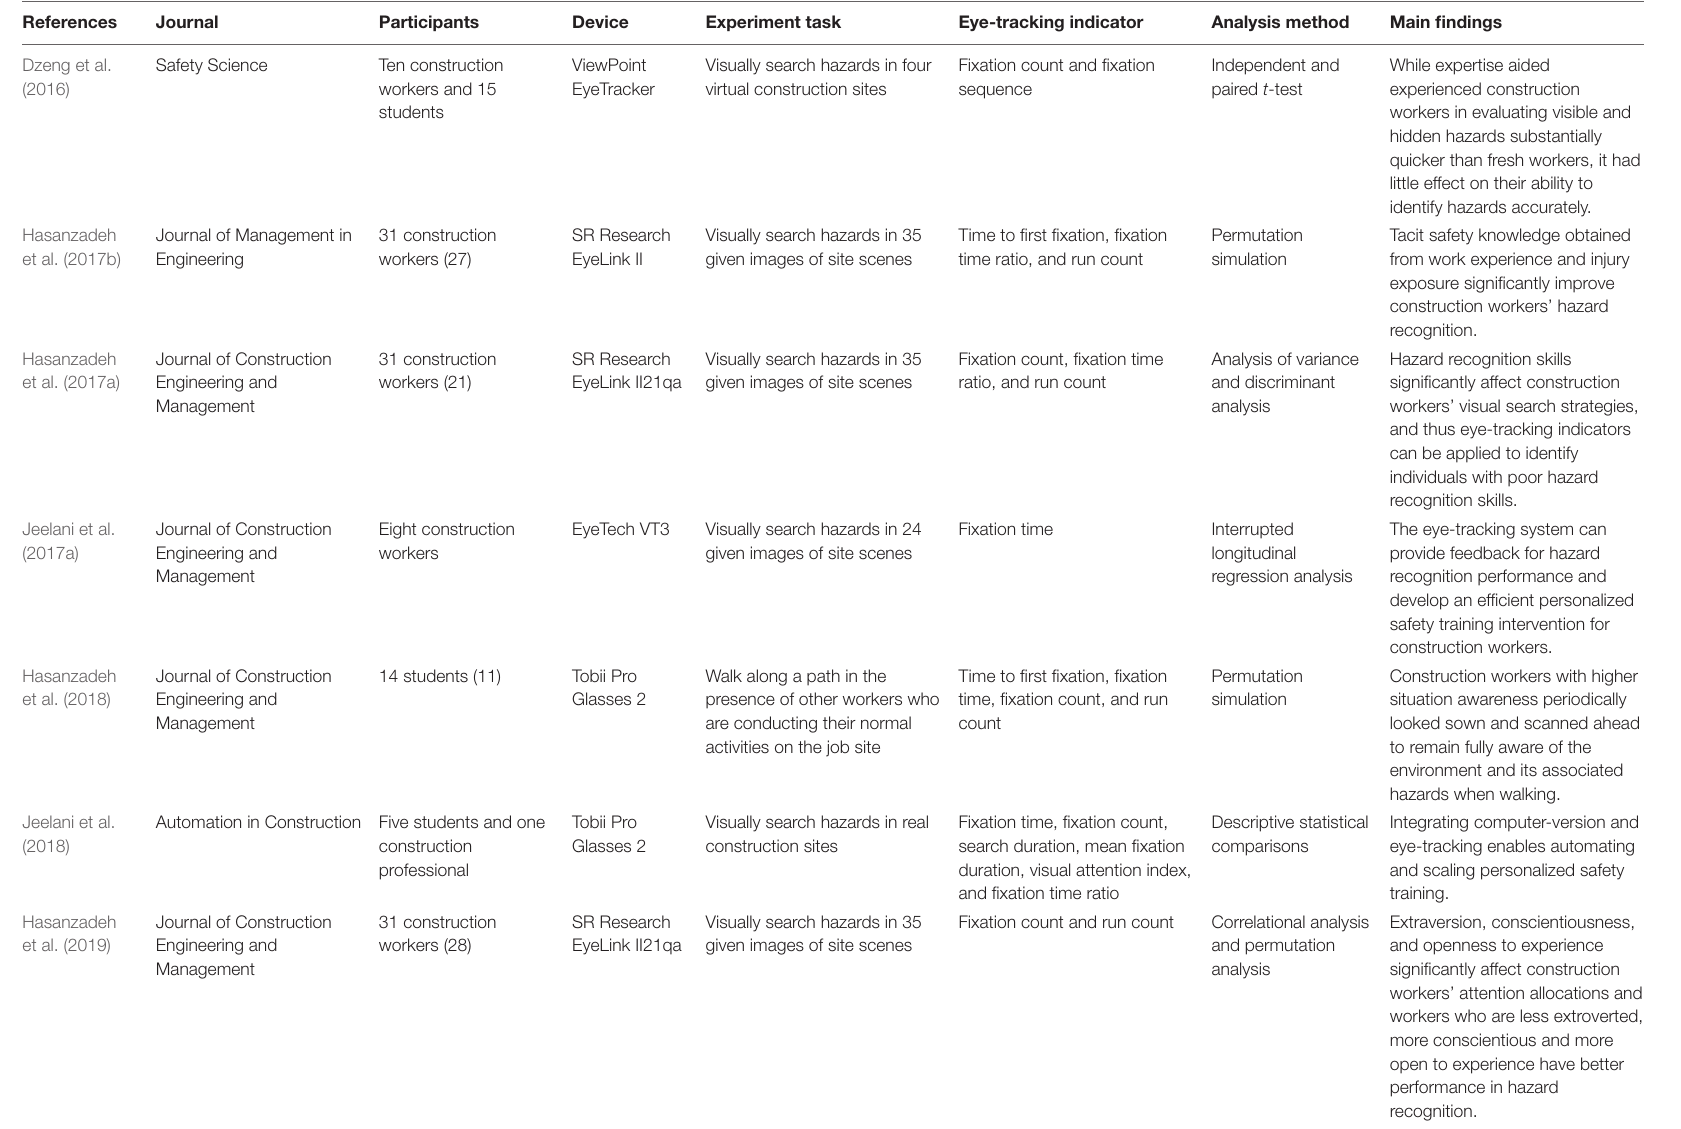
TABLE 1 | Summary information of existing eye-tracking studies in construction